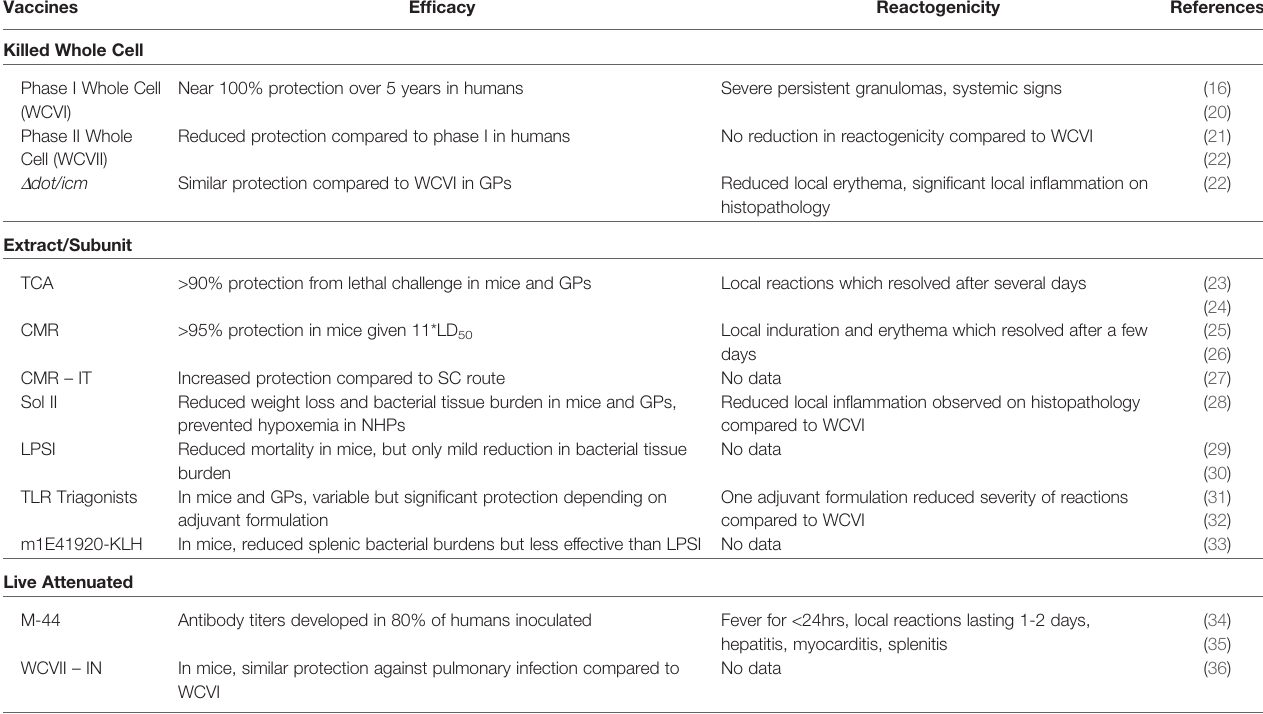
TABLE 1 | Summary table of published C. burnetii vaccine strategies tested in humans or animal models. Vaccines Ef fi